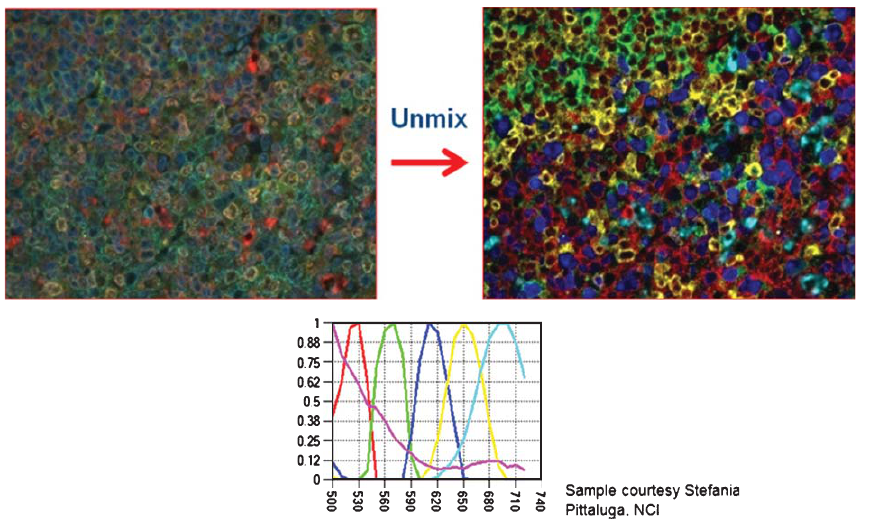
Fig. 5. Five quantum dots plus DAPI spectrally imaged, unmixed and displayed. The DAPI spectrum is shown, but the DAPI signal is not included in the composite